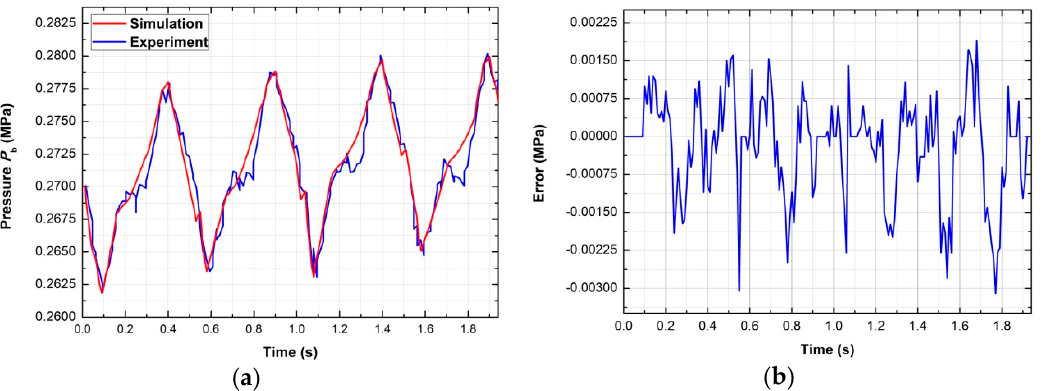
Figure 26. Pressure curve of chamber b and its error curve: ( a ) Pressure curve; ( b ) Error.